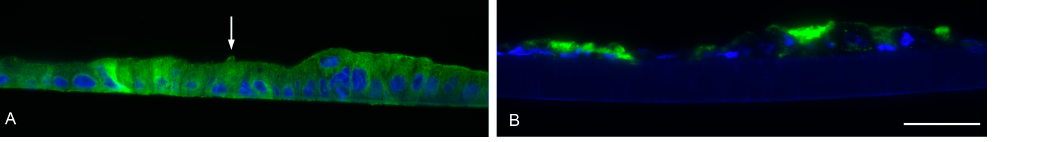
Figure 1. Immunochemical detection of tubulin ( A ) and identification of mucus-producing cells by anti-mucin 5AC staining ( B ). Tubulin is contained in high amounts in cilia and in lower amounts in the cytoskeleton. In the absence of cilia, the staining of the cytoskeleton and of immature cilia (arrow) is visible. Scale bar: 50 µm.